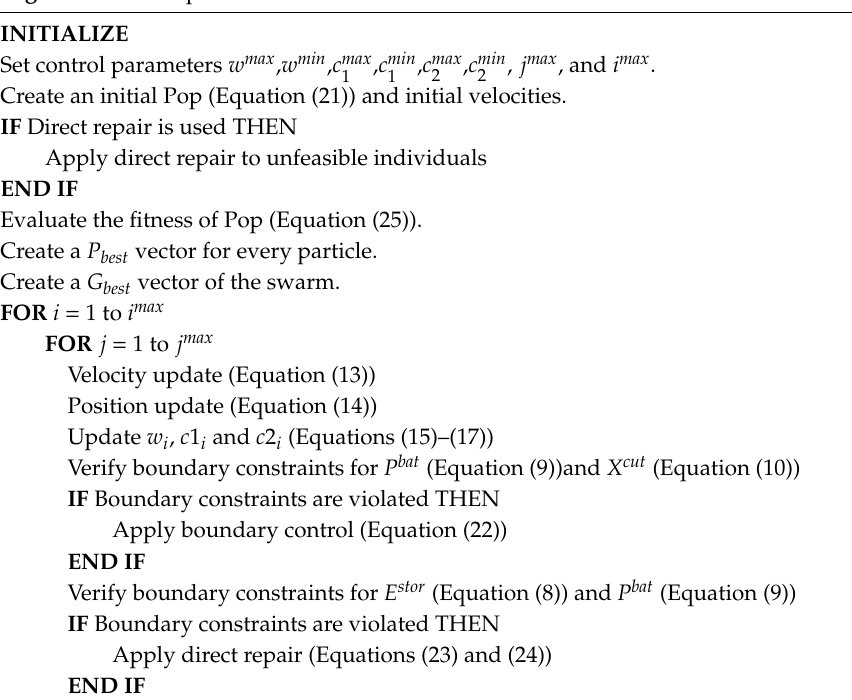
Algorithm 1. PSO